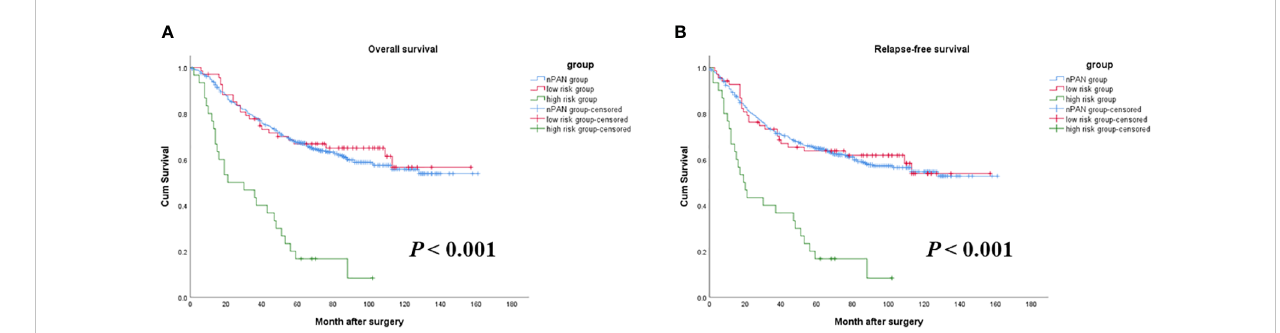
FIGURE 4 Survival curves for SPAN patients with low risk, high risk and nPAN. (A) sPAN patients with high risk had much worse OS than those with low risk and nPAN ( p < 0.001); (B) sPAN patients with high risk had much worse RFS than those with low risk and nPAN ( p < 0.001). sPAN, small para-aortic lymph node; nPAN, non para-aortic lymph node; OS, overall survival; RFS, relapse-free survival; GC, gastric